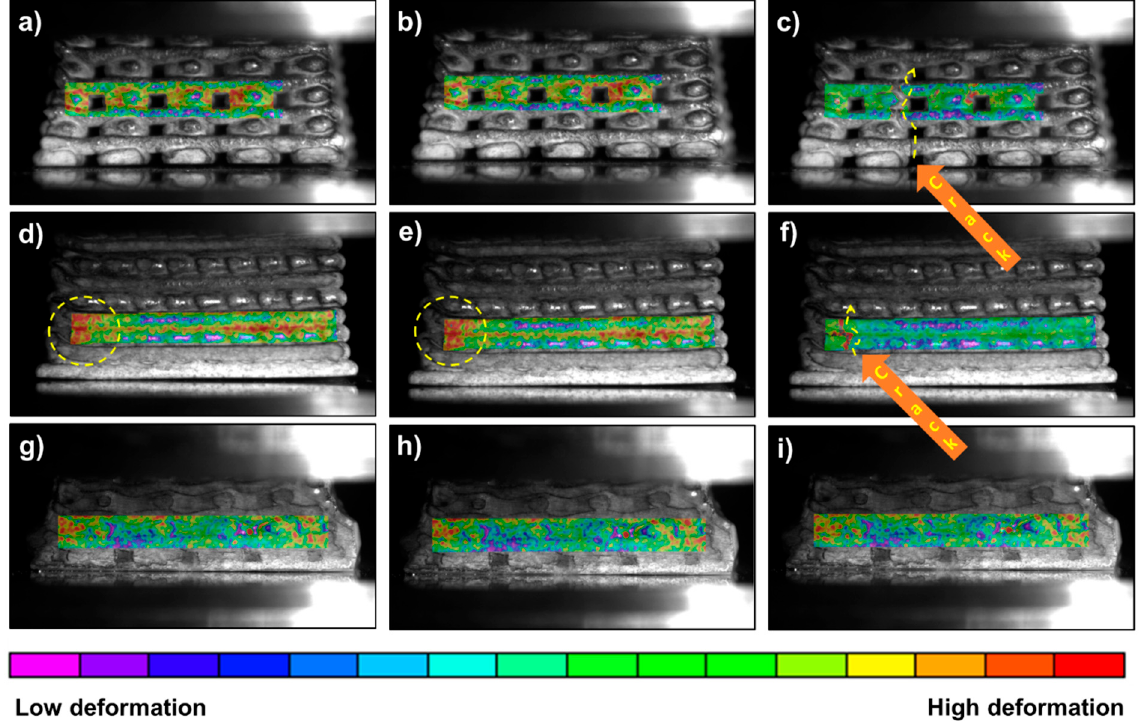
Figure 5. Digital images progress of deformation in the 3D-printed scaffolds, under a compression experiment: ( a – c ) 50% infill of 3D-printed zirconia, ( d – f ) 100% infill, ( g – i ) PICN sample (50% infill of 3D-printed zirconia with infiltrated copolymer). Dashed yellow arrows indicate the direction of filaments breaking, orange arrows indicate the crack propagation and yellow dashed circles show the zone with high deformation under compression, characterized by an deep red color.